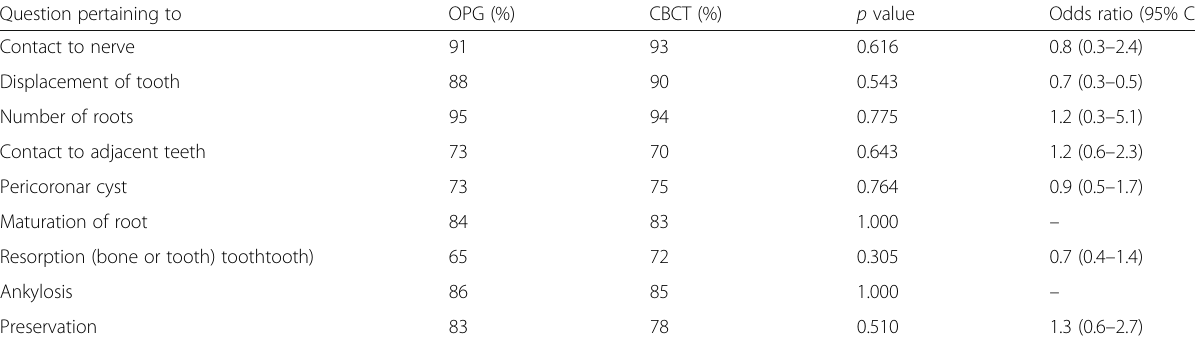
Table 4 Accuracy of the diagnostic answers given, according to imaging modality: OPG versus CBCT Question pertaining to OPG (%) CBCT (%) p value Contact to